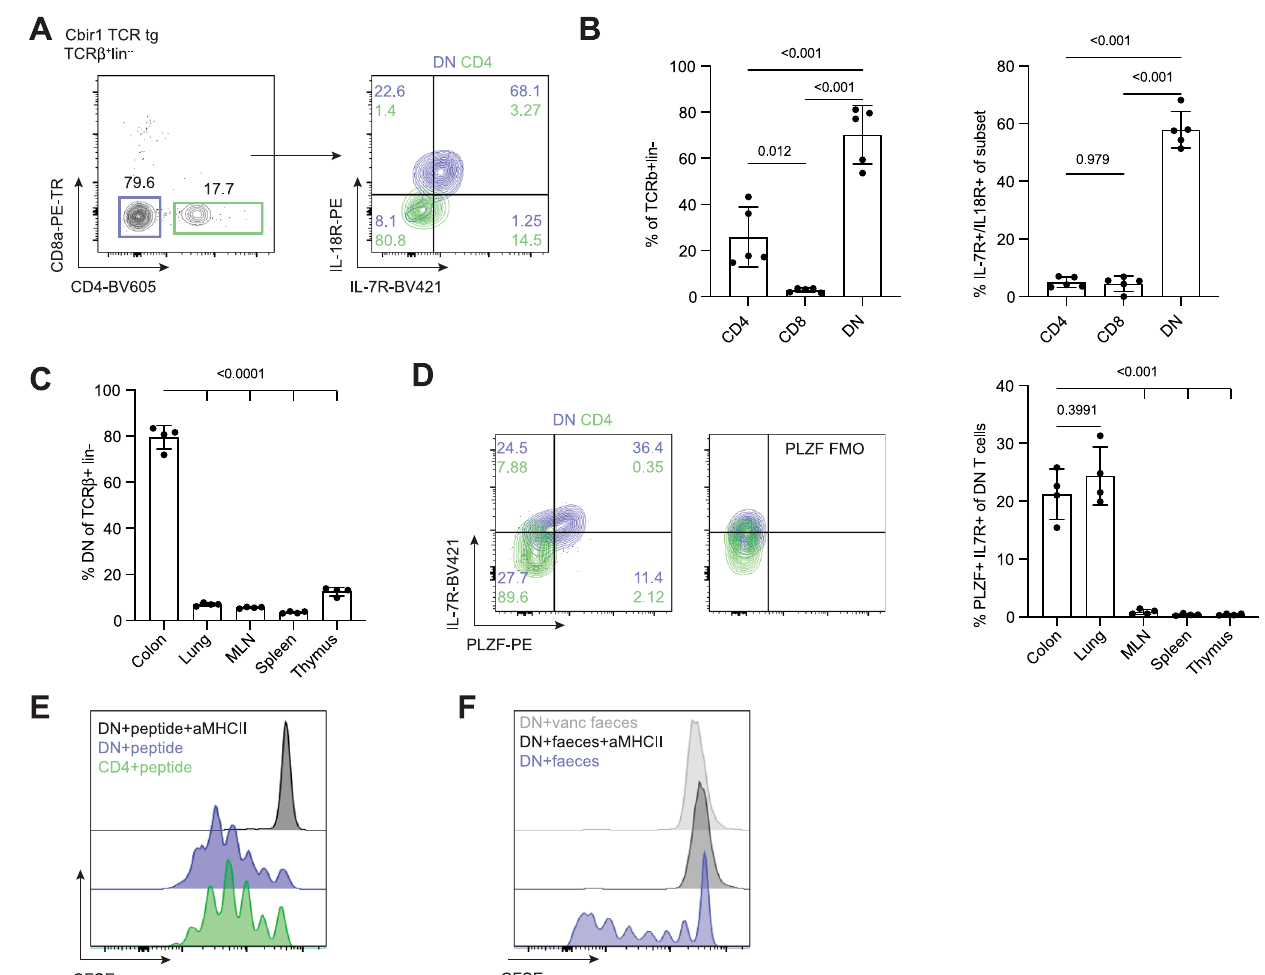
Fig. 3 | Cbir1, MHC-II restricted, microbe-reactive TCR transgenic develop an innate-likephenotype in the gut. LPLs from Cbir1 TCR transgenic line crossedto Rag − / − mice were analyzed directly ex vivo or stimulated in vitro. A Flow cyto- metric analysis of TCR β +lin − cells from the colon lamina propria of Cbir1 Rag − / − mice stained for CD4 and CD8a. (left) and IL-7R and IL-18R stain of the gated CD4 (green) and CD4/CD8 double negative (DN, blue) cell populations (right). FACS plots are representative of experiments n =5, representative of two independent experiments. B Quanti fi cation of fl ow cytometry data showing the percent of the TCR β +lin − population that are CD4, CD8a, and DN (left), and the percent of each population that have the IL-18R/IL-7R expressing phenotype (right). Each point represents an individual animal. n =5, representative of two independent experi- ments.Meanwithstandarddeviationshown,one-wayANOVAwithTukey ’ smultiple comparison test. C Quanti fi cation of FACS data of the percent of T cells with a DN phenotype from Cbir1colon LPL, lung,mesenteric lymph node (MLN), spleen, and